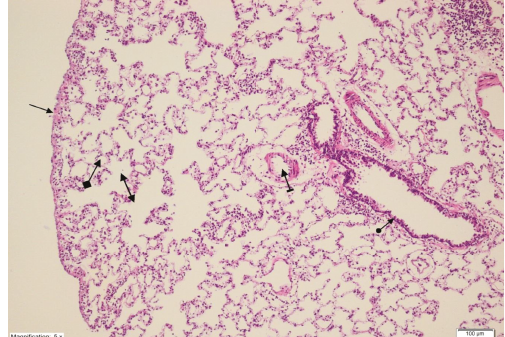
Figure 7: Healthy pleural mesothelium (straight arrow), healthy pulmonary arterioles (dashed arrow), normal bronchiole (round arrow) structure and alveolar structure (squared arrow), and normal histological structure of the alveolar channels (double arrow) in the lung tissue of the HG group (H&E × 100).